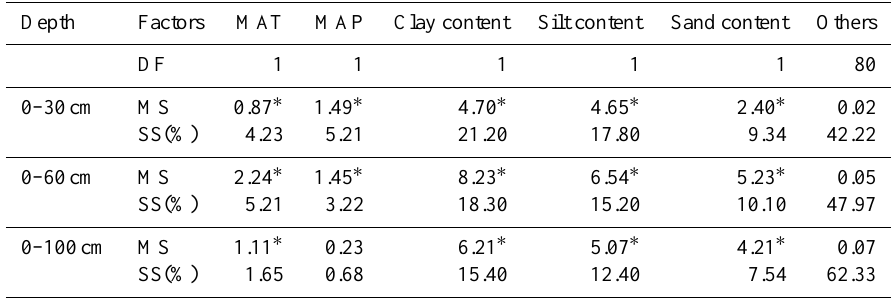
Table 2. GLM results for correlating SOCD and environmental factors.